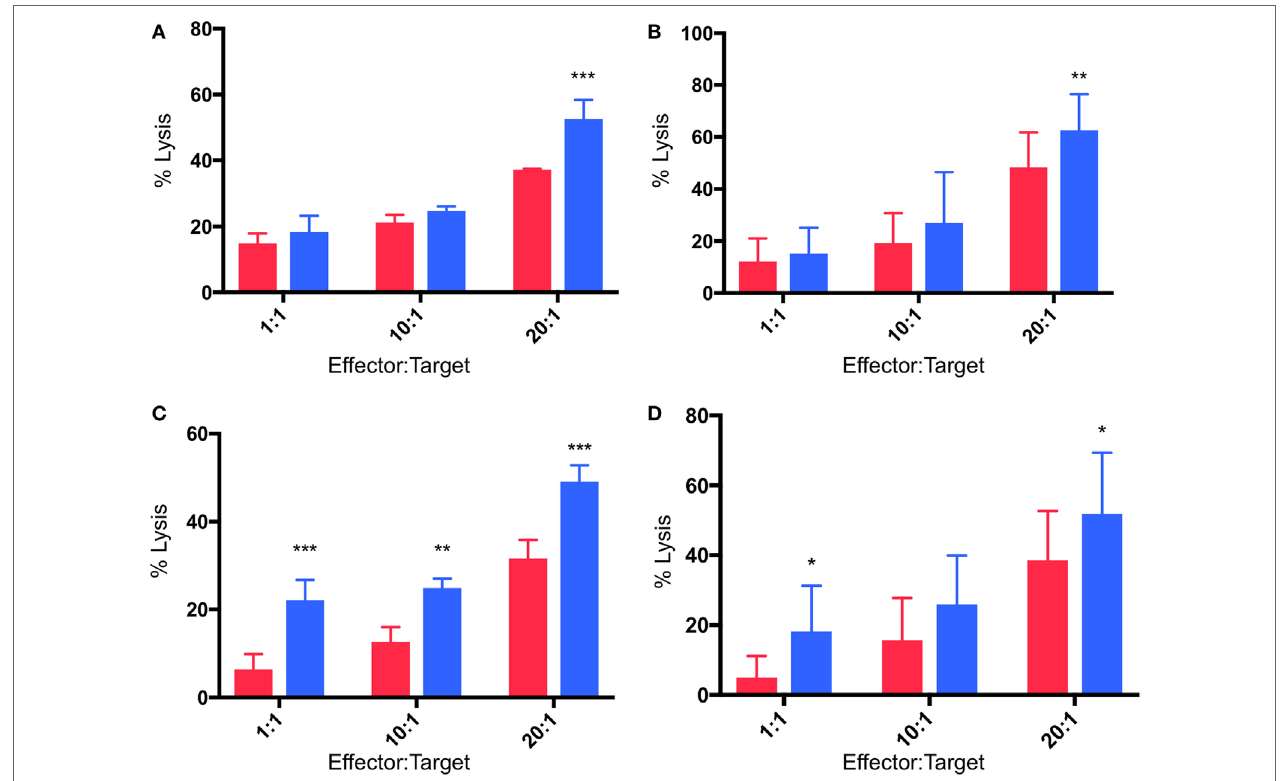
FigUre 5 | Enhanced cytotoxicity of gamma delta T cells ( γδ Tcs) cultured in hypoxia. Cytotoxicity assays comparing γδ Tc cultured in 20% (red bars) or 2% O 2 (blue bars) 48 h prior to co-culture with breast cancer target lines cultured at 20% O 2 . (a) A representative example of γδ Tc targeting MCF-7 cells; (B) compiled results from six independent experiments with γδ Tc cultures from five different donors targeting MCF-7; (c) a representative example with T47D targets; (D) compiled results from five independent experiments with γδ Tc cultures from four different donors targeting T47D. Two-way ANOVA, * P < 0.05, ** P < 0.01, *** P <